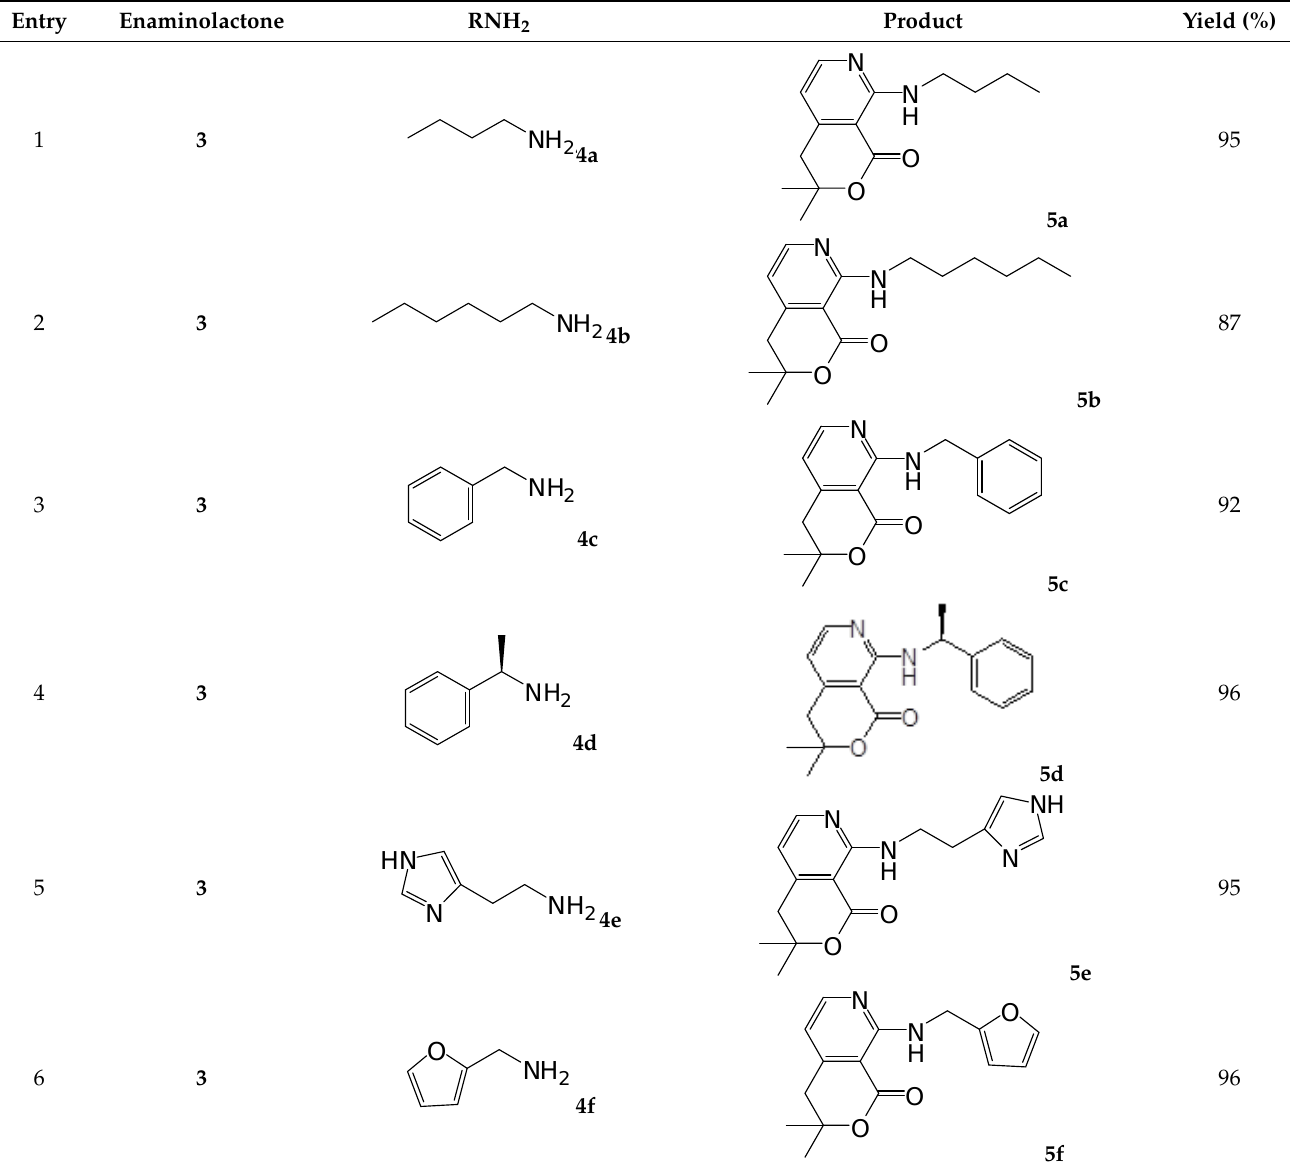
Figure 3. Synthesis of 2-aminopyridines 5a-f from enaminolactone nitrile 3. Table 1. Synthesis of 2-aminopyridine lactones. Table 1. Synthesis of 2-aminopyridine lactones. Table 1. Synthesis of 2-aminopyridine lactones. Table 1. Synthesis of 2-aminopyridine lactones. Table 1. Synthesis of 2-aminopyridine lactones. Table 1. Synthesis of 2-aminopyridine lactones. Table 1. Synthesis of 2-aminopyridine lactones. Table 1. Synthesis of 2-aminopyridine lactones. Table 1. Synthesis of 2-aminopyridine lactones.